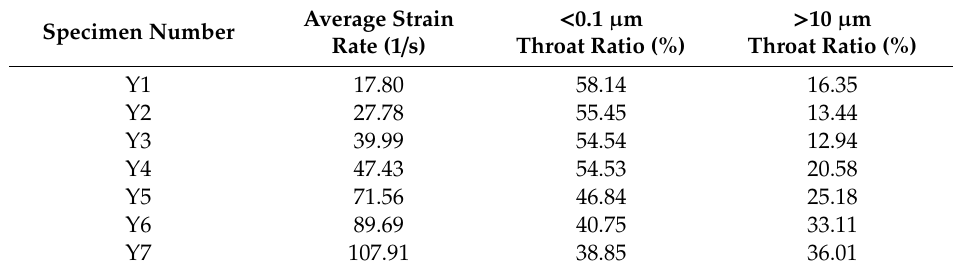
Table 2. The proportion of micro- and macro- throats within crushed specimens of Xintian coal. Specimen